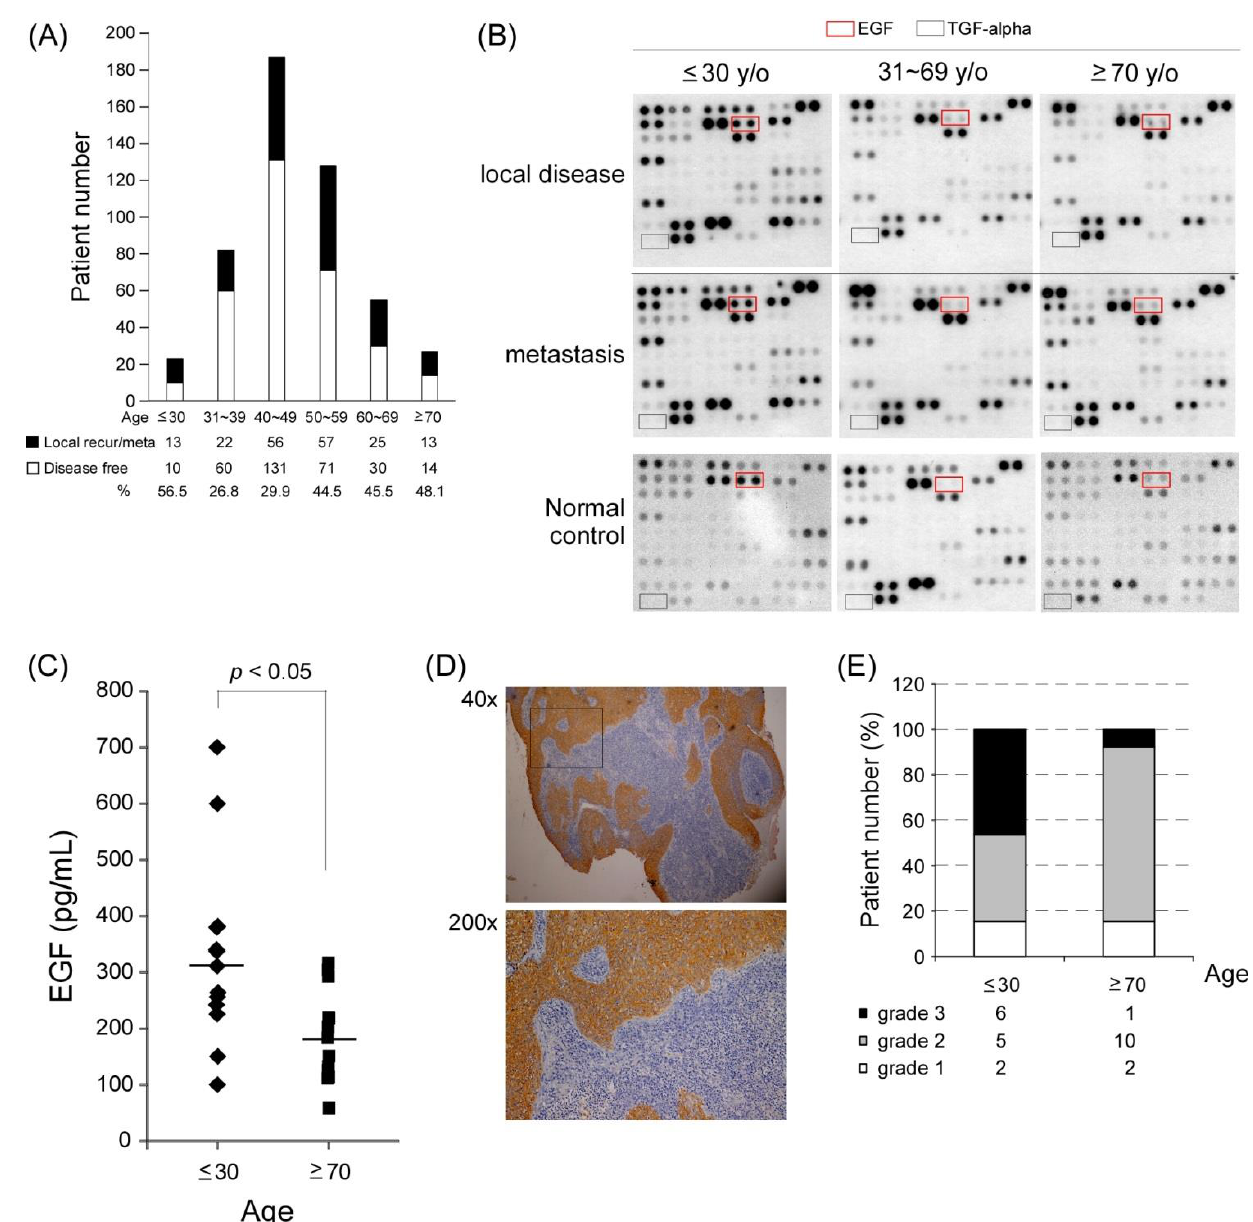
Figure 1. Various age groups of patients with NPC and the EGFEGFR pathway. ( A ) Patient distribution according to age groups. Patients aged ≤ 30 and ≥ 70 years had a higher rate of local recurrence and metastasis (black bar) when compared with other age groups. ( B ) Findings of the plasma cytokine array in different age groups of patients with metastatic NPC. Epithelial growth factor receptor (EGFR) ligands, including EGF and TGF-alpha, were screened in different age groups with local disease or distant metastasis. ( C ) The mean plasma EGF levels of patients with recurrent or metastatic NPC were 310.9 pg/mL in those aged ≤ 30 years ( n = 13) and 183.2 pg/mL in those aged ≥ 70 years ( n = 13; t -test, p < 0.05). ( D ) IHC staining results of EGFR expression (grade 3) in one NPC tumor tissue. ( E ) Tissue EGFR expression in patients with NPC aged ≤30 ( n = 13) and aged ≥70 years ( n = 13; grade 3, black bar; grade 2, grey; and grade 1, white).